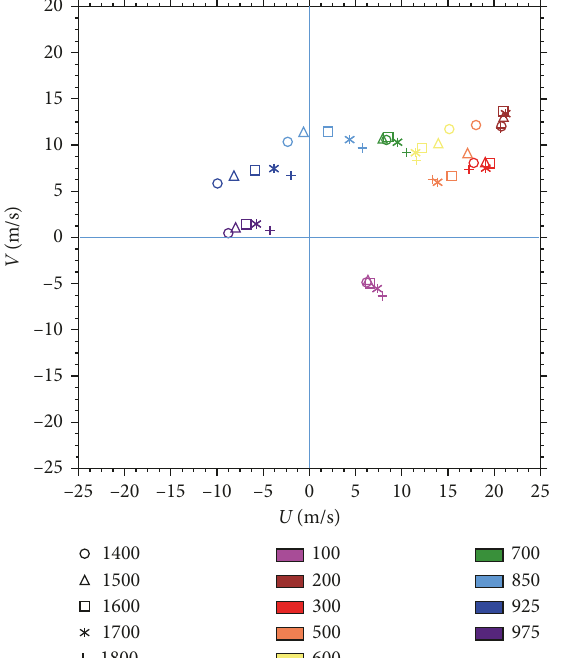
Figure 12: Changes of domain averaged horizontal wind with height in the western half of the key rainstorm area during 1400-1800 UTC 4 July 2014. Different colors represent different heights (unit: